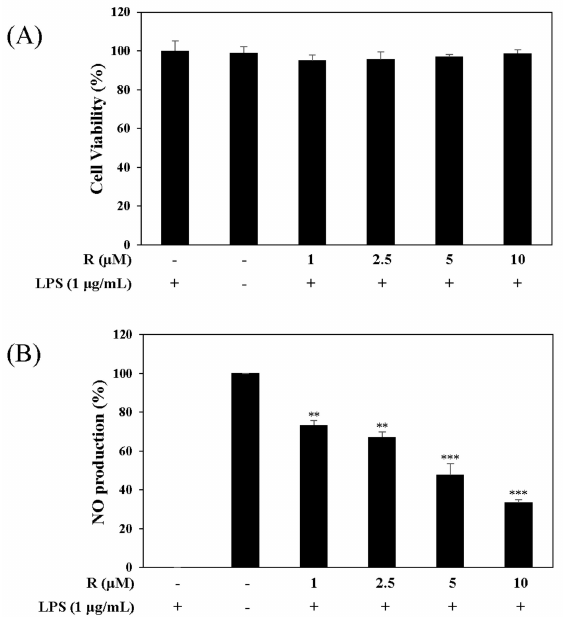
Figure 4. E ff ects of R on cell viability ( A ) and NO production ( B ). RAW 264.7 cells were treated with R for 1 h and stimulated with LPS (1 µ g / mL) for 16 h. Cell viability and NO production were detected using the MTT assay and Griess reagent, respectively. Nitrite concentrations of non-treated and LPS-treated controls were 0.8 ± 0.1 µ M and 17.3 ± 0.2 µ M, respectively. Each experiment was performed in triplicate. The data are represented as the mean ± SD. * p < 0.05, ** p < 0.01, *** p < 0.001 vs. LPS-treated